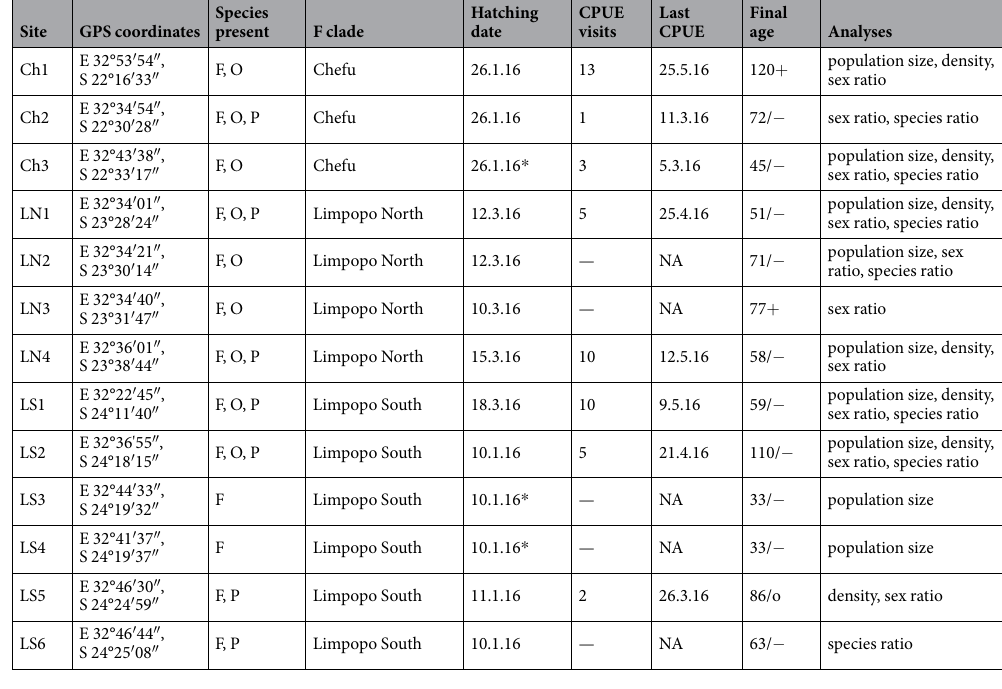
Table 1. Summary table for data obtained from the study sites. The abbreviation for Nothobranchius species present are F for N. furzeri , O for N. orthonotus and P for N. pienaari . F clade is phylogeographic lineage of N. furzeri 31 . Hatching date was estimated based on otolith readings and for sites, where not collected ( * ), the hatching date was estimated based on the hatching date estimates for fish in nearby sites (Supplementary Table 1). Final age is number of days the fish reached during our monitoring. The fish were present until pool desiccation (/ − ), fish disappeared, while the pool was still present (/o), or fish survived longer than the sites were monitored ( + ) (see also Fig.